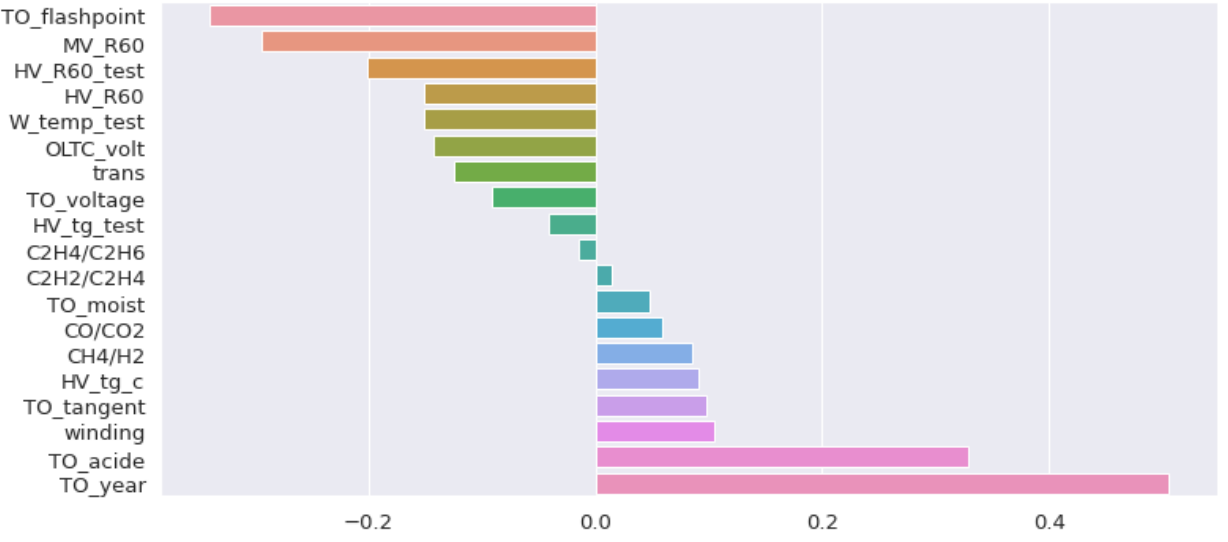
Figure 13. Spearman correlation coefficients in relation to the state of the power transformer.